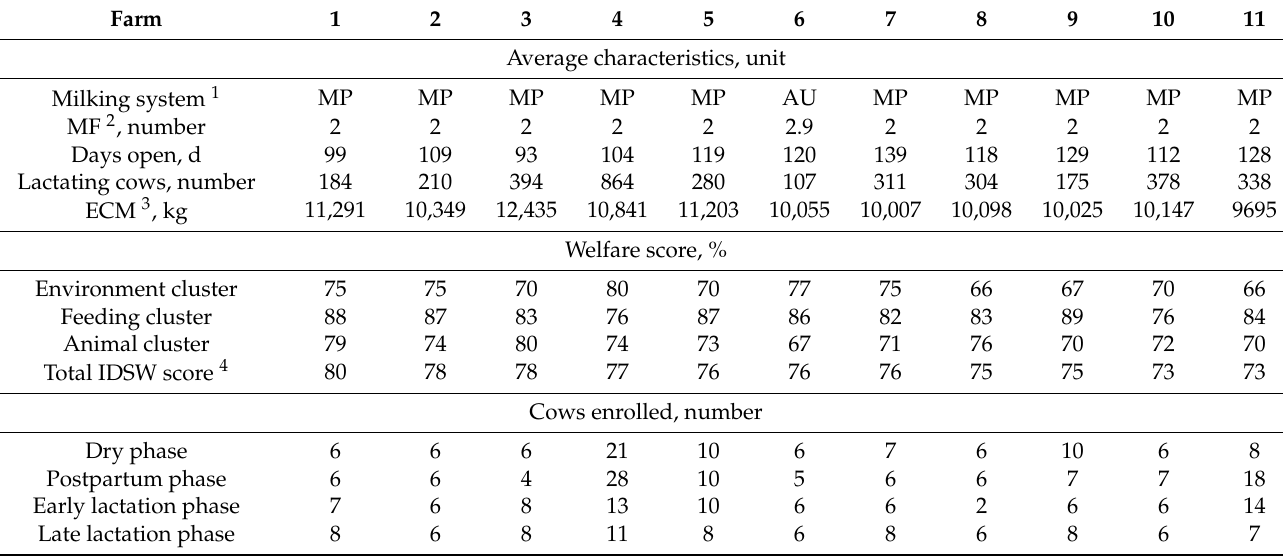
Table 1. Average characteristics, welfare score assigned, and number of cows enrolled for blood collection in the 11 high welfare farms selected for assessing physiological variations of plasma analytes in high welfare raised multiparous Holstein dairy cows during the pivotal stages of the lactation